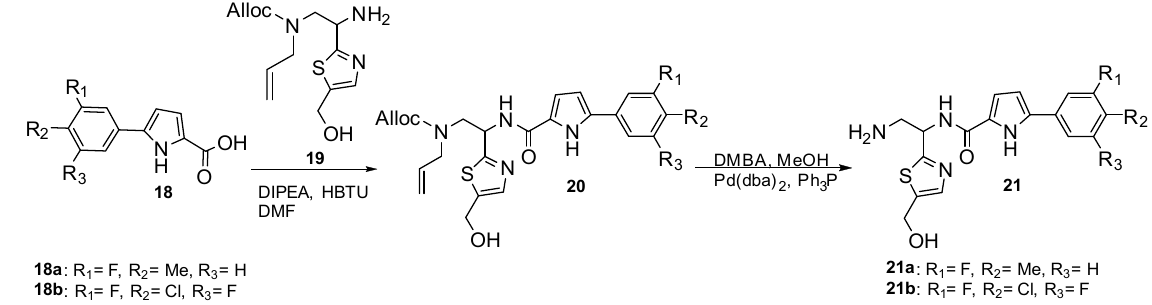
Scheme 5. The synthesis of pyrrole derivatives as glycoprotein inhibitors of HIV-1.